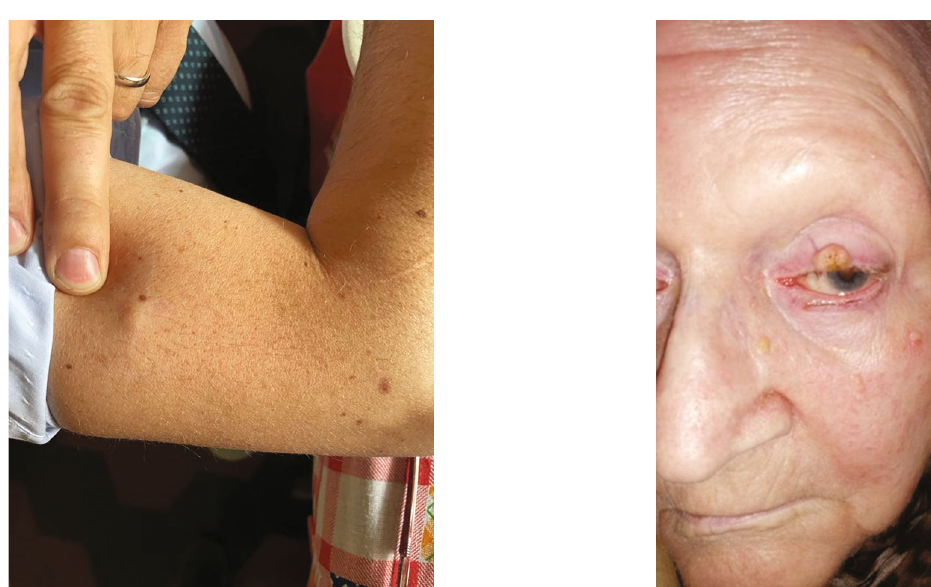
Figure 9: Skin lump 48 hours after treatment with spontaneous regression at 1 month.